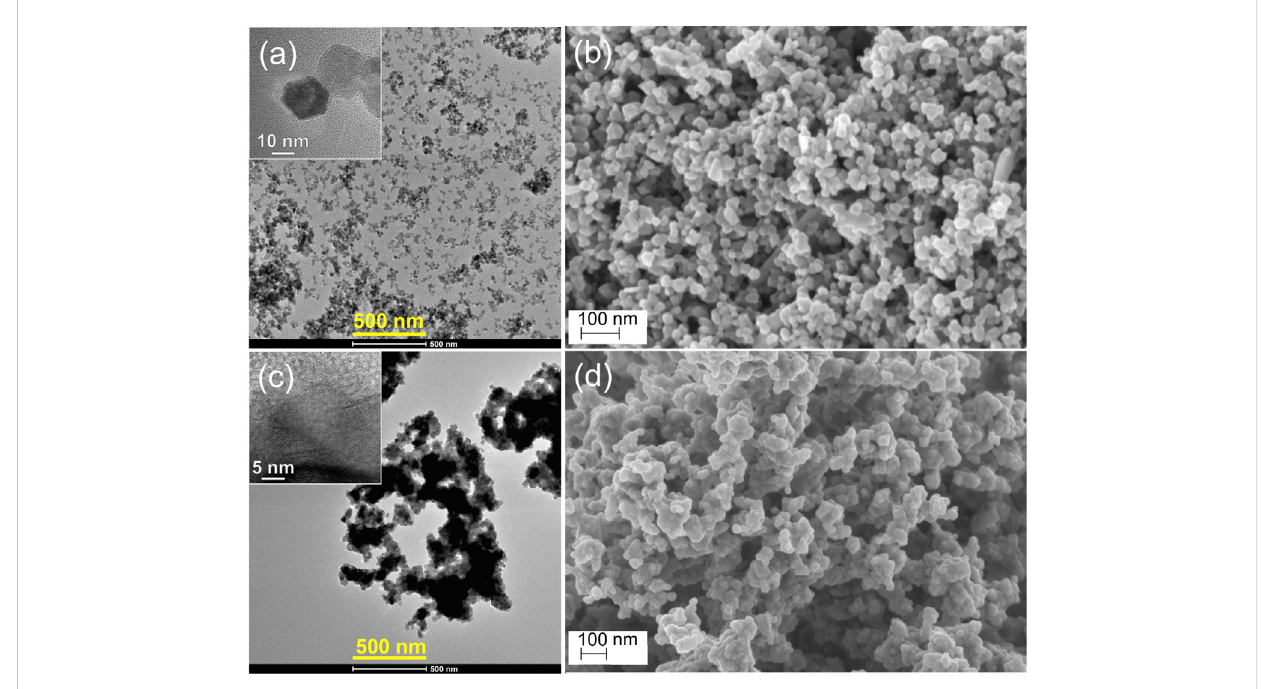
FIGURE 5 TEM/HRTEM and FESEM images of (A, B) pristine ZnO, and (C, D) bare RuO 2 particles. Bar is 500 nm in the TEM images and 100 nm in the FESEM images.